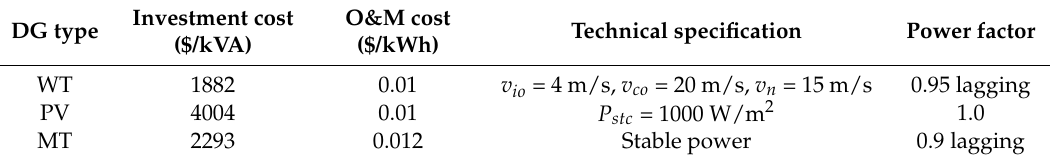
Table 1. Technical specification parameters of different types of distributed generation (DGs).